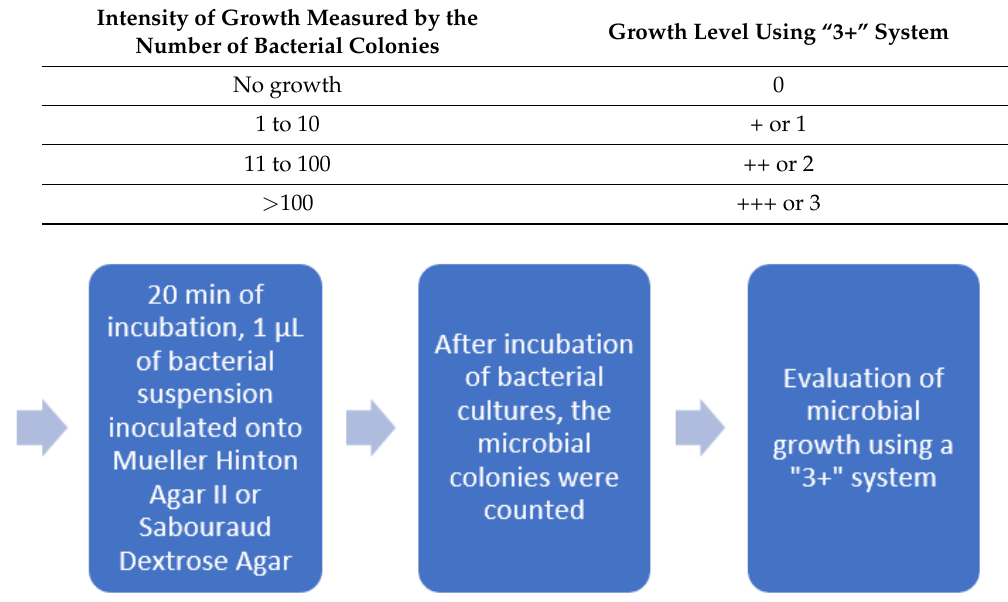
Figure 2. Preparation of microorganisms for the evaluation after direct contact with CuO nanoparticles. For control purposes, the middle layer of a 3-ply medical mask (XianTao Hong Tai as the experimental mask layer with